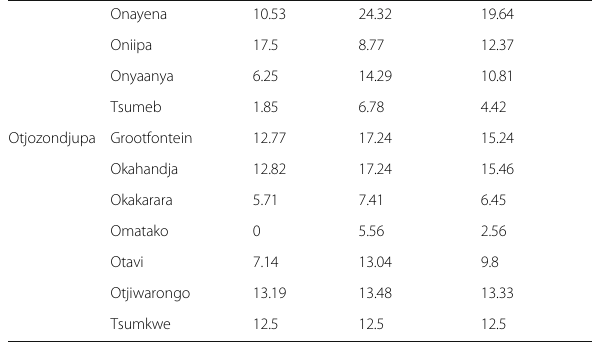
Table 7 Fixed effects and their 95% credible intervals (CI): Separate model for NDHS